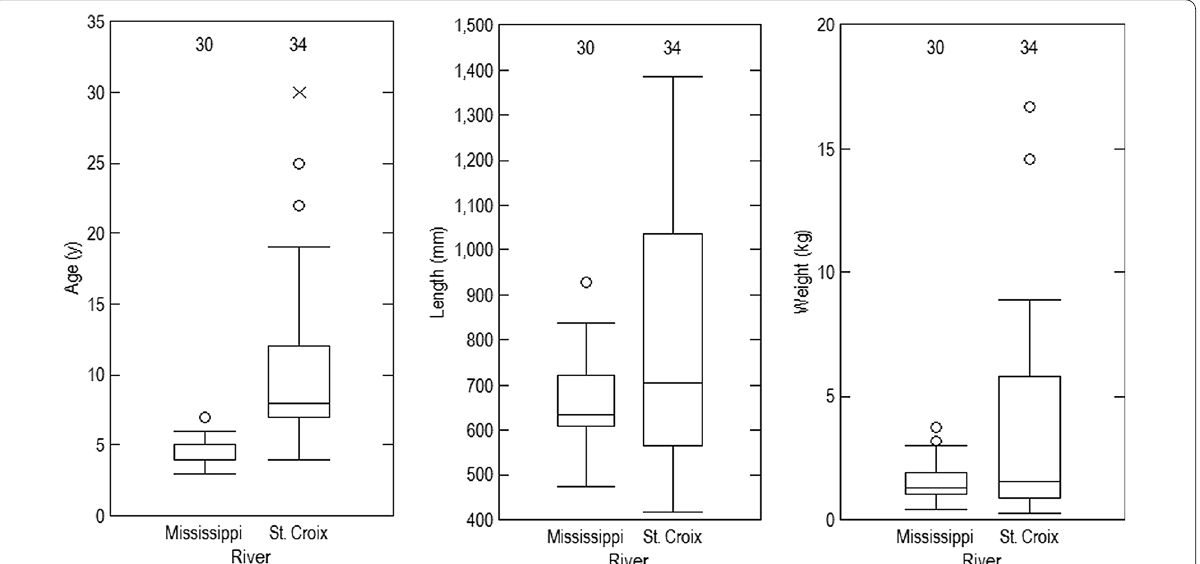
Fig. 3 Boxplots illustrating distributions of age, length, and weight data for lake sturgeon captured in the Mississippi ( n Rivers. Boxes represent the interquartile ranges, with center lines in representing median values and the upper and lower ends of the boxes representing the 75th and 25th percentiles, respectively. Whiskers represent values within 1.5 times of the interquartile range, either above the 75th percentile or below the 25th percentile. Values plotted as open circles represent values within 3 times the interquartile